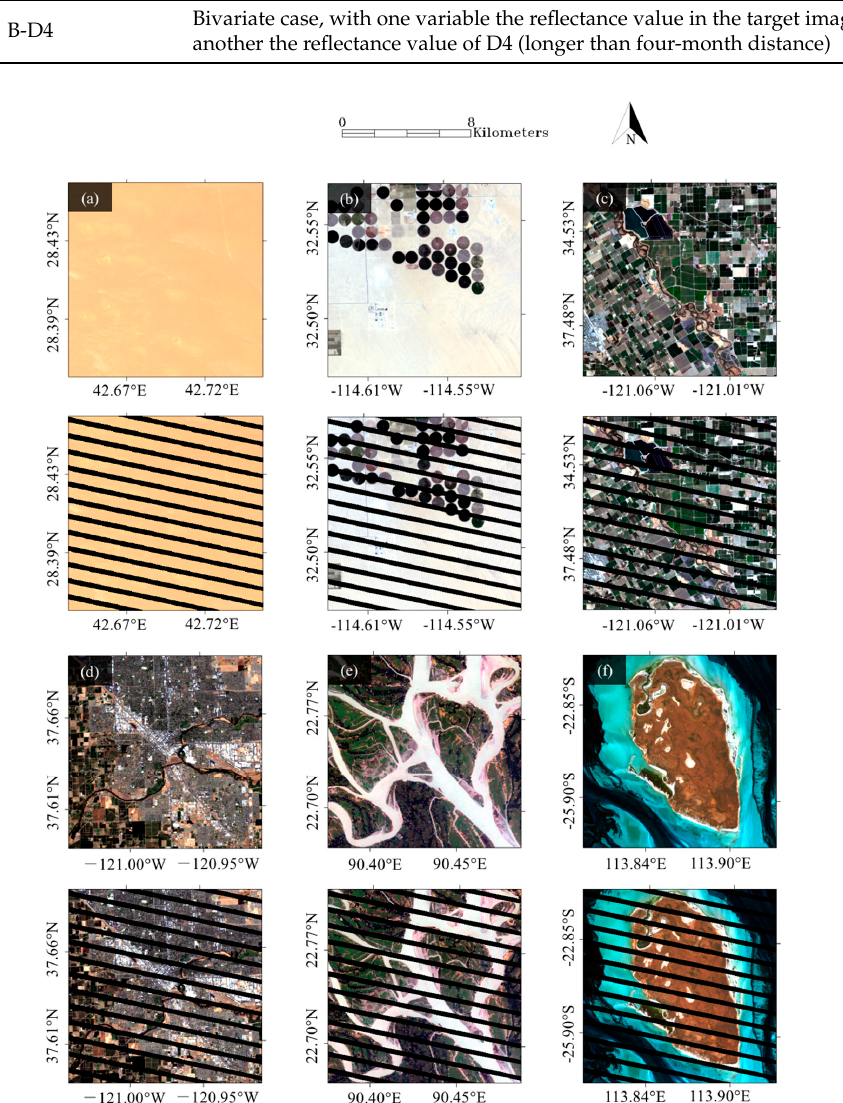
Figure 4. Target images for each of the studied regions, both with and without imposed gaps, for ( a ) desert; ( b ) sparse agricultural; ( c ) dense farmland; ( d ) urban; ( e ) braided river and ( f ) coastal area.